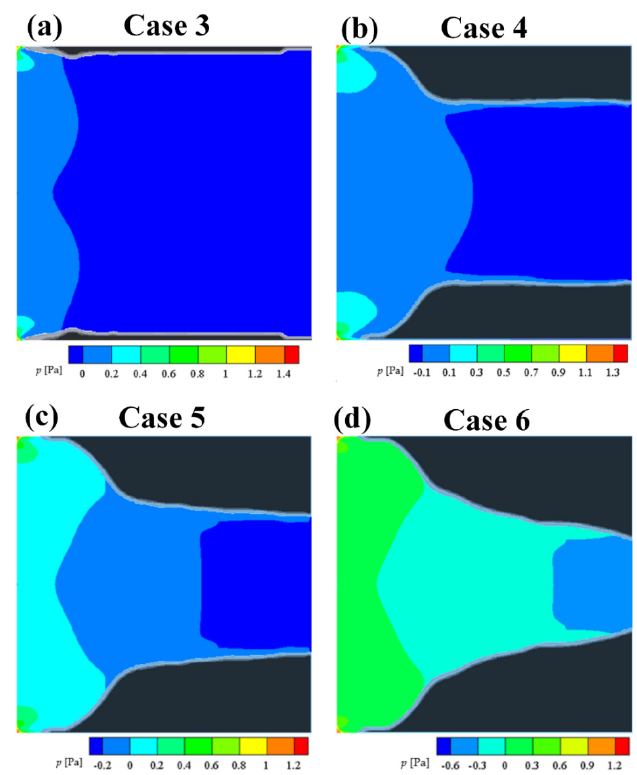
Figure 15. Contour of fluid pressure (Pa) at t = 0.4 s under various initial ice phase distribution state ( a ) Case 3, ( b ) Case 4, ( c ) Case 5, and ( d ) Case 6.